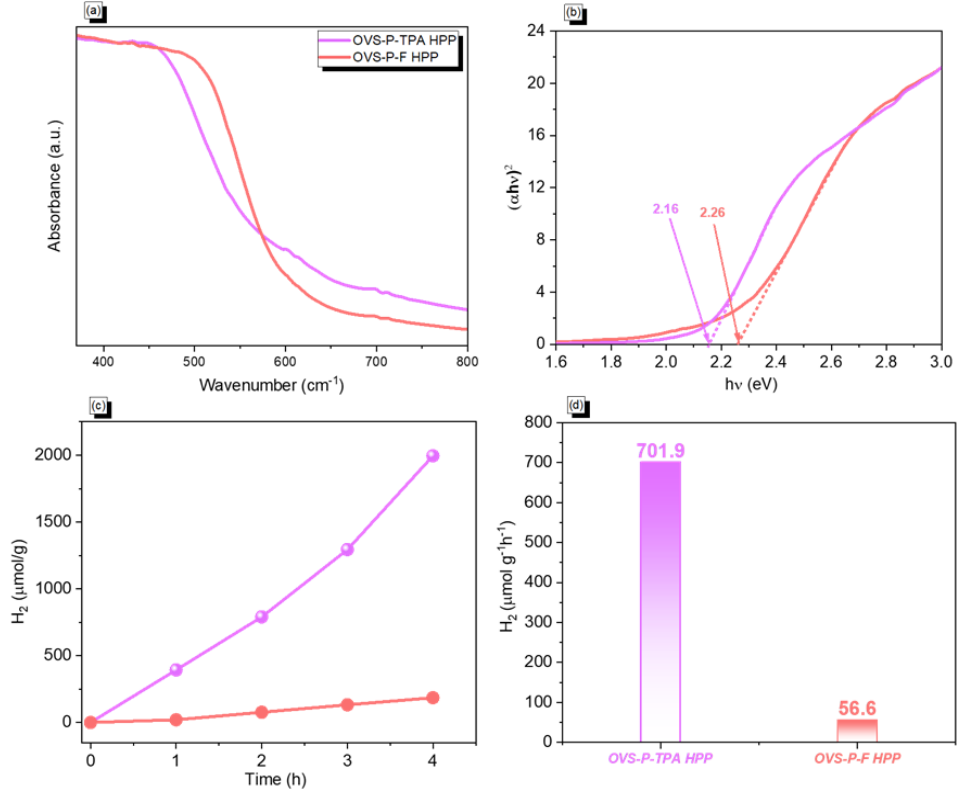
Figure 8. ( a ) UV-Vis DRS absorption spectra of the OVS-HPPs, ( b ) the Tauc plot of (αhν) 2 versus (hν) from the UV -Vis spectra for calculating the bandgap of the OVS-HPPs, ( c ) time course of the produced H 2 , and ( d ) HER of the two polymers. Conditions: ascorbic acid (AA, 0.1 M) and a xenon lamp light source (AM1.5, λ > 380 nm, and 1000 W m −2 ).